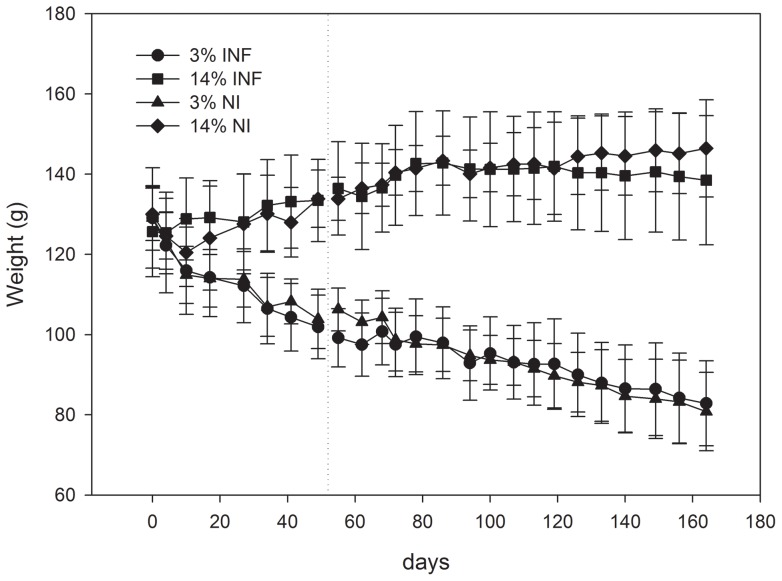
Growth of infected and non-infected hamsters fed the standard (14%) and protein-deficient (3%) diets.Changes in body weight were assessed every seven days. The dotted vertical line indicates the moment of intracardiac infection. Data show means of one representative experiment of two independent assays. The differences in mean body weight between hamsters on the different diets were statistically significant: *p<0.05, **p<0.01, ***p<0.001.